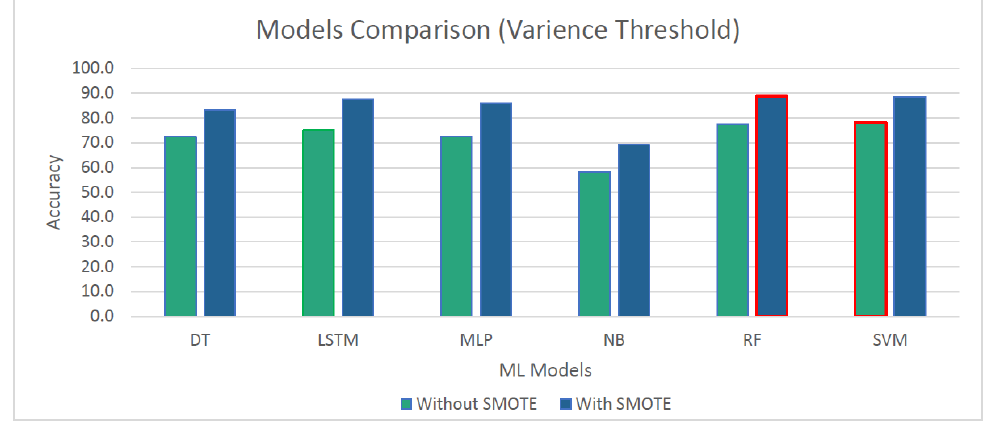
Figure 14. Exp3 Models